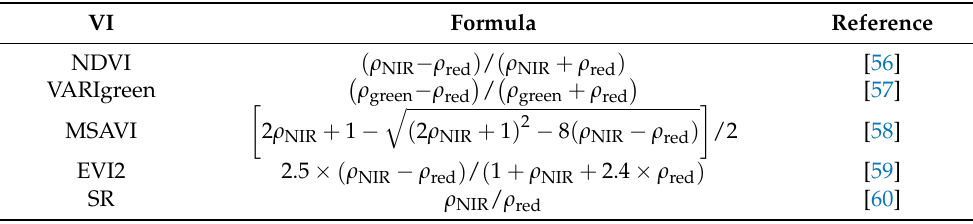
Table 4. Vegetation indices tested in this study. All indices were calculated from reflectance collected by Gaofen-1